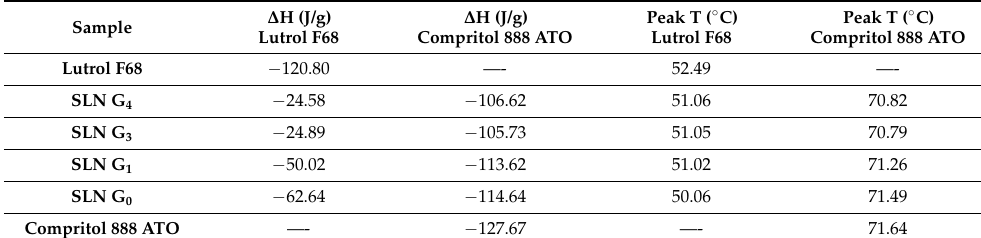
Table 4. Enthalpy variations ( ∆ H) and peak temperatures of Lutrol F68, Compritol 888 ATO, and lyophilized SLNs.